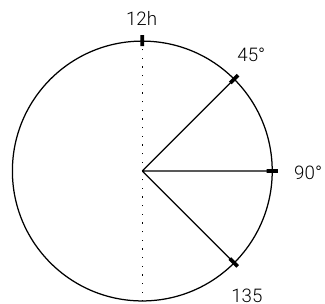
Figure 1. Description of the directions considered for measuring the surface